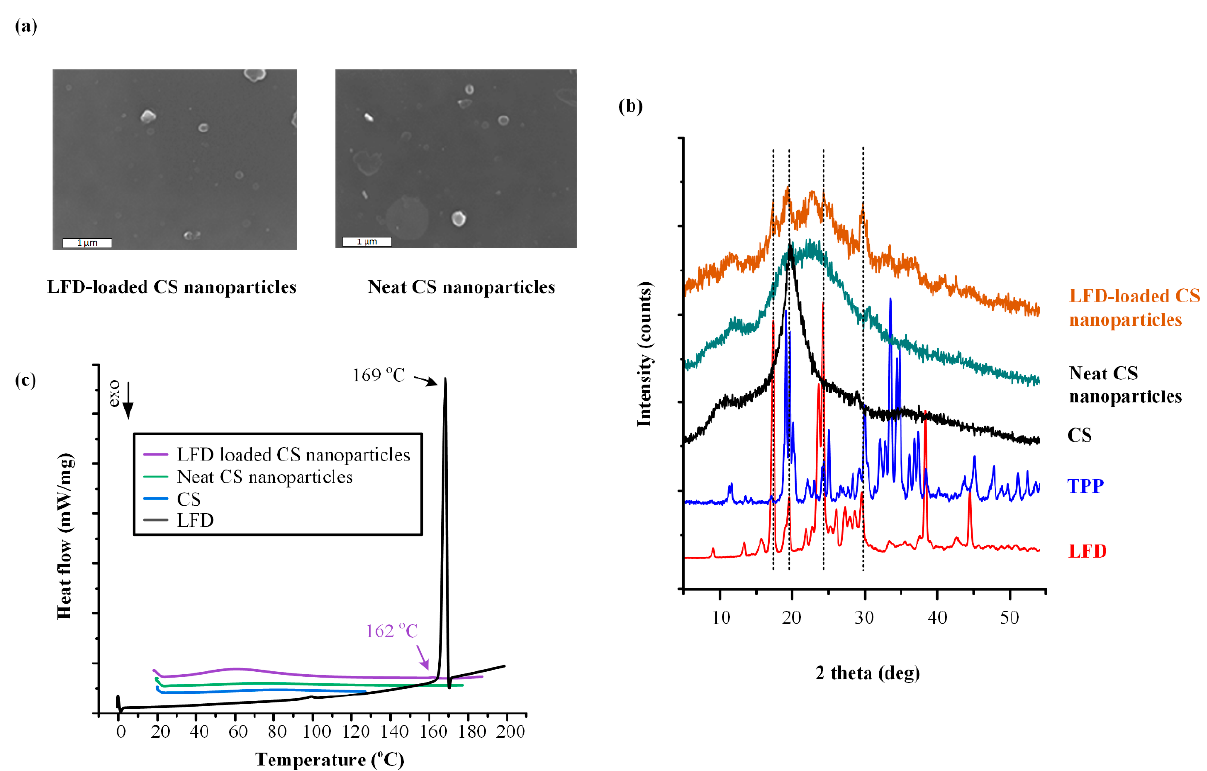
Figure 1. FESEM images ( a ), pXRD diffractograms ( b ), and DSC thermograms ( c ) for the neat chitosan (CS) nanoparticles (NPs) and the leflunomide (LFD)-loaded CS NPs that will be embedded into the poly(l-lactic acid) (PLLA) and poly(lactic co glycolic acid) (PLGA) thin-film patches.